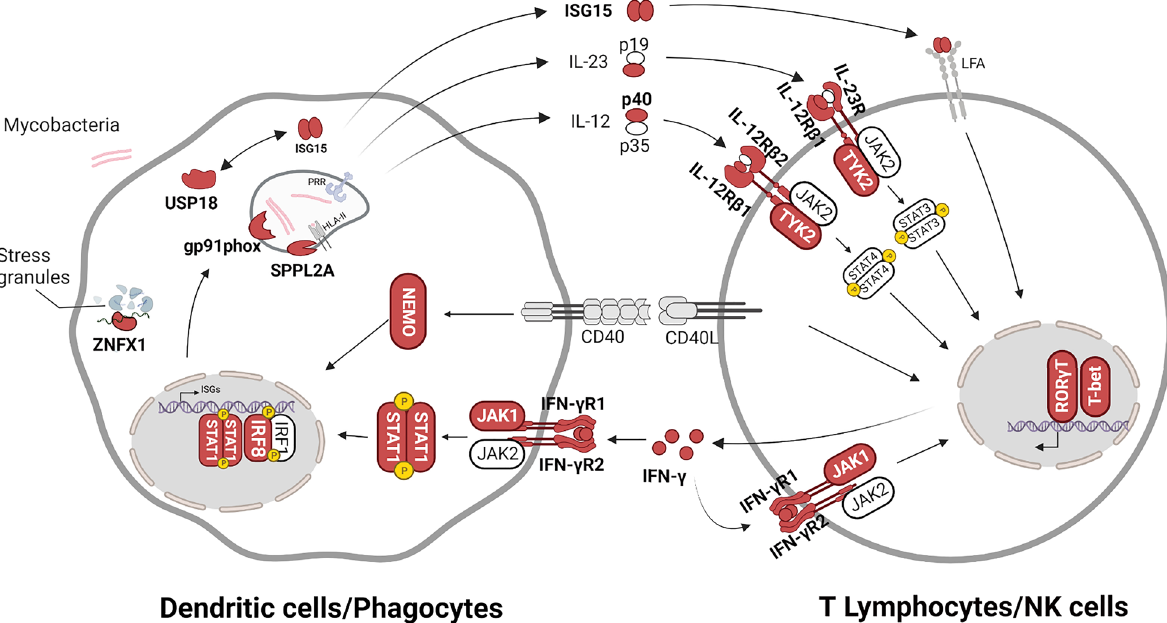
Fig. 1 Schematic diagram of the cooperation between phagocytes/dendritic cells and T/NK cells during mycobacterial infection. Proteins for which mutations in the corresponding genes have been associated with MSMD are indicated in red. Following phagocytosis of mycobacteria, pattern recognition receptors (PRRs) activate and induce the production and release of IL‑12, IL‑23, and ISG15. These cytokines bind to their receptors (IL‑12R, IL‑23R, and LFA‑1) on T‑helper and NK cells, inducing the production of IFN‑ γ via TYK2/JAK2‑dependent pathways, using STAT4 and STAT3 dimers, as well as the transcription factors RORC and T‑bet. In turn, secreted IFN‑ γ binds to its receptor (IFN γ R) on the surface of macrophages and dendritic cells leading to the activation of JAK1/JAK2‑dependent pathway involving STAT1, IRF8, and IRF1 transcription factors, which enhances the production of IL‑12, IL‑23, and ISG15 and promotes expression of interferon‑stimulated genes (ISGs). USP18 liberates ISG15 from other bound proteins and ISG15 protects USP18 from degradation. Besides, the interaction of CD40 with its ligand leads to the activation of NEMO, which activates and releases the NF‑kB transcription factors. This enhances the ability of phagocytes to eliminate intracellular